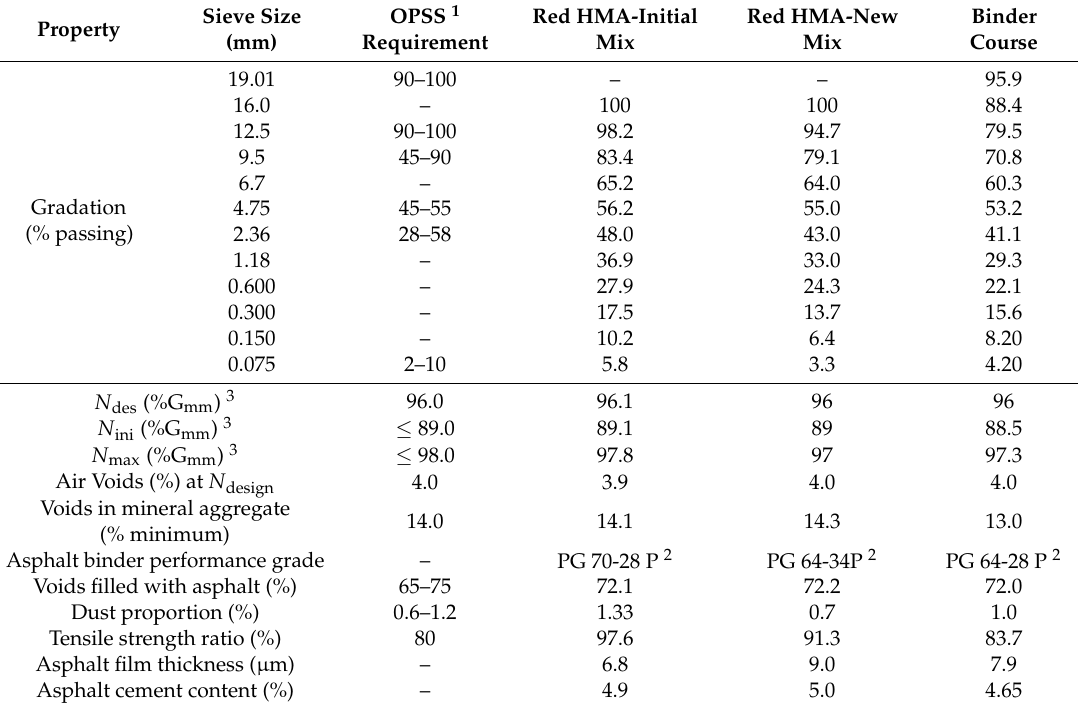
Table 2. Red hot-mix asphalt and binder course asphalt